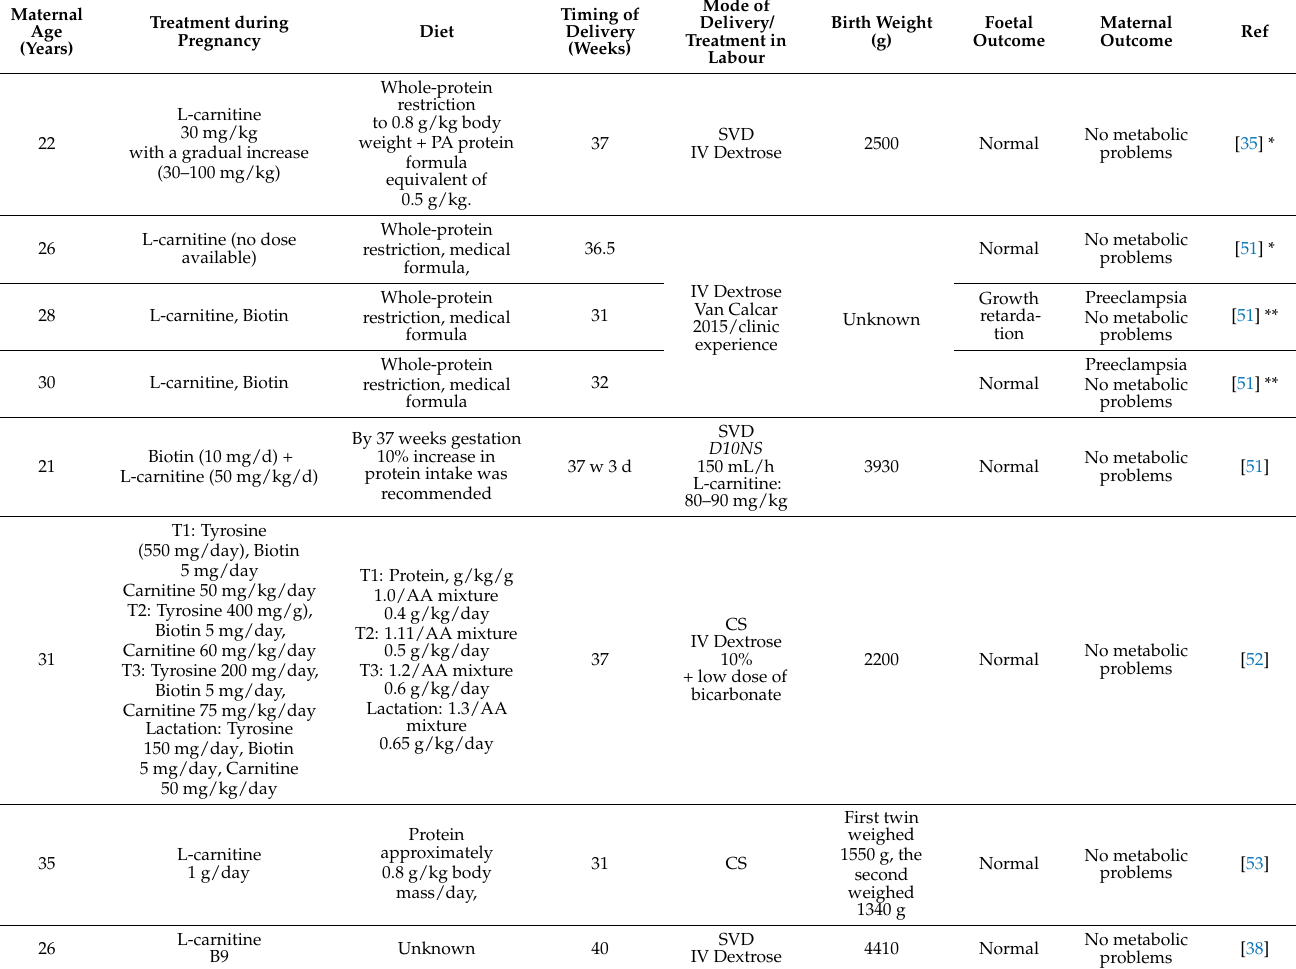
Table 3. Published literature on pregnancies in